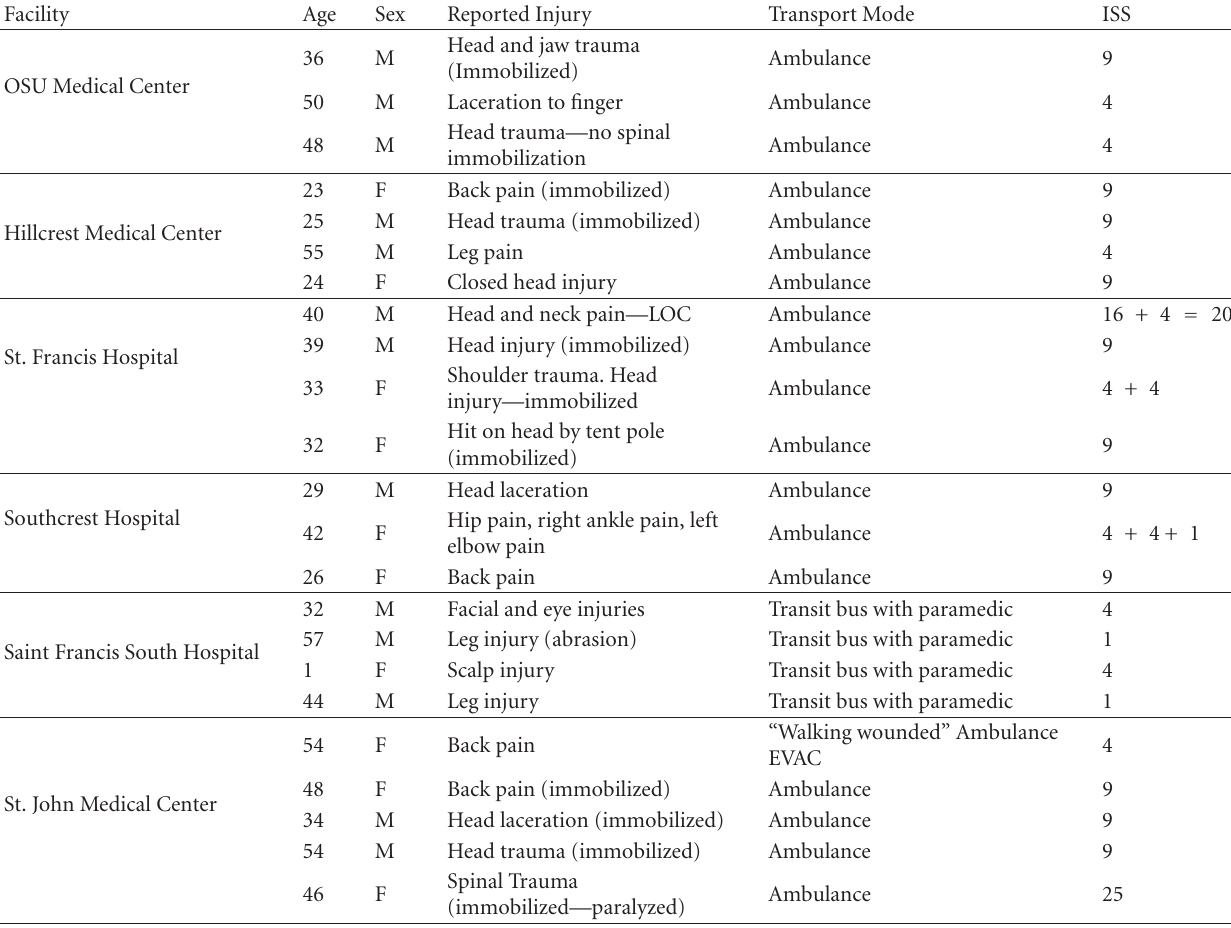
Table 1: Transported Patient Summary. Injury severity code = sum of squares of the AIS grade in each of the three most severely injured areas as described by Baker et al. [2]. Injury severity score for these transported patients was assigned from description in the transport records, vital signs, and was verified by three of the